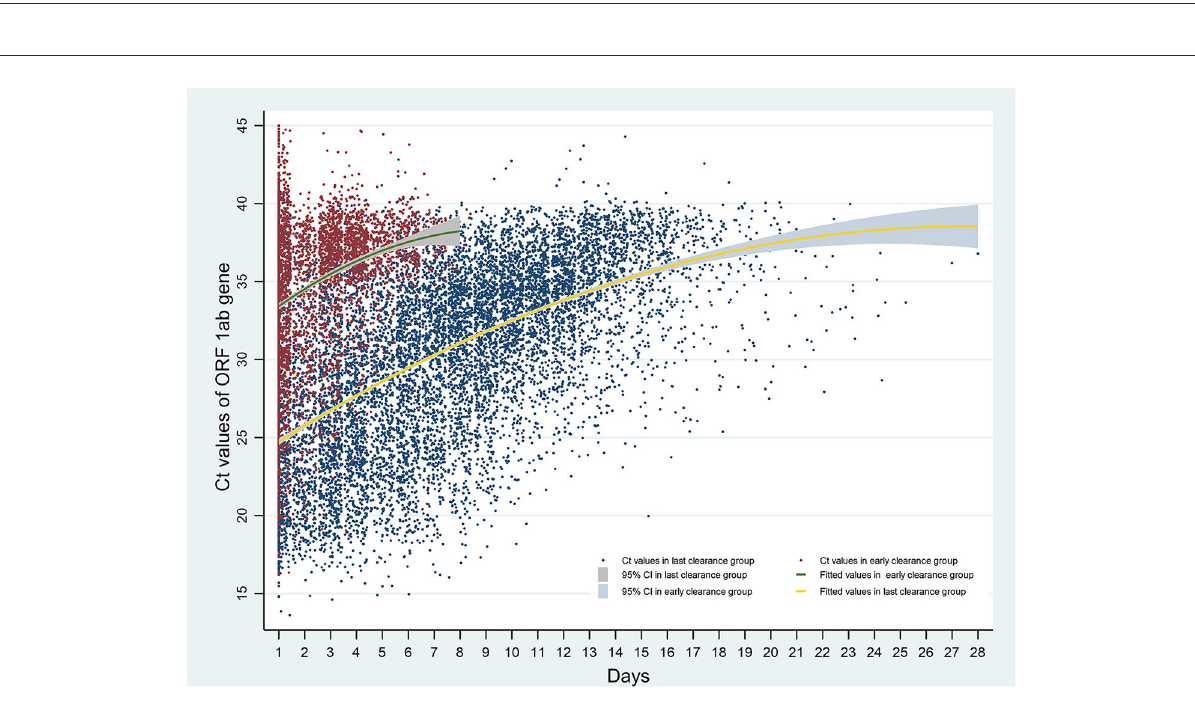
FIGURE4 Ct values of ORF 1ab gene over time after admission. Ct, cycle threshold; ORF 1ab gene, open reading frame